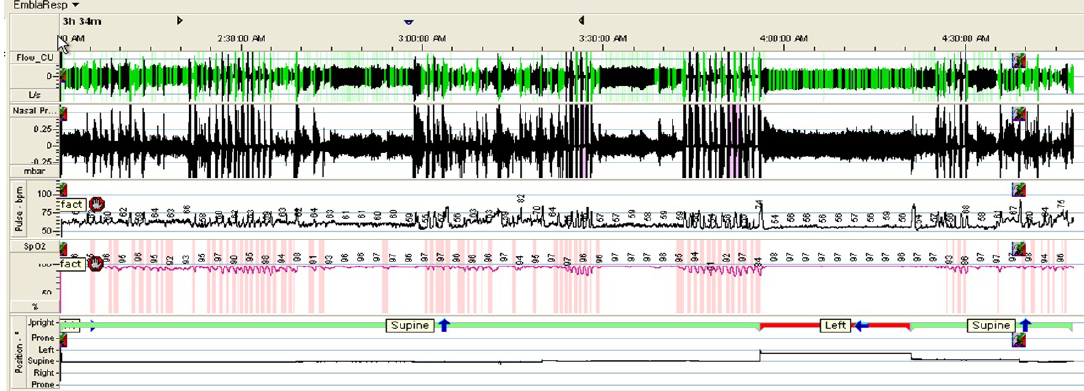
Figure 5. Example of signals obtained from the